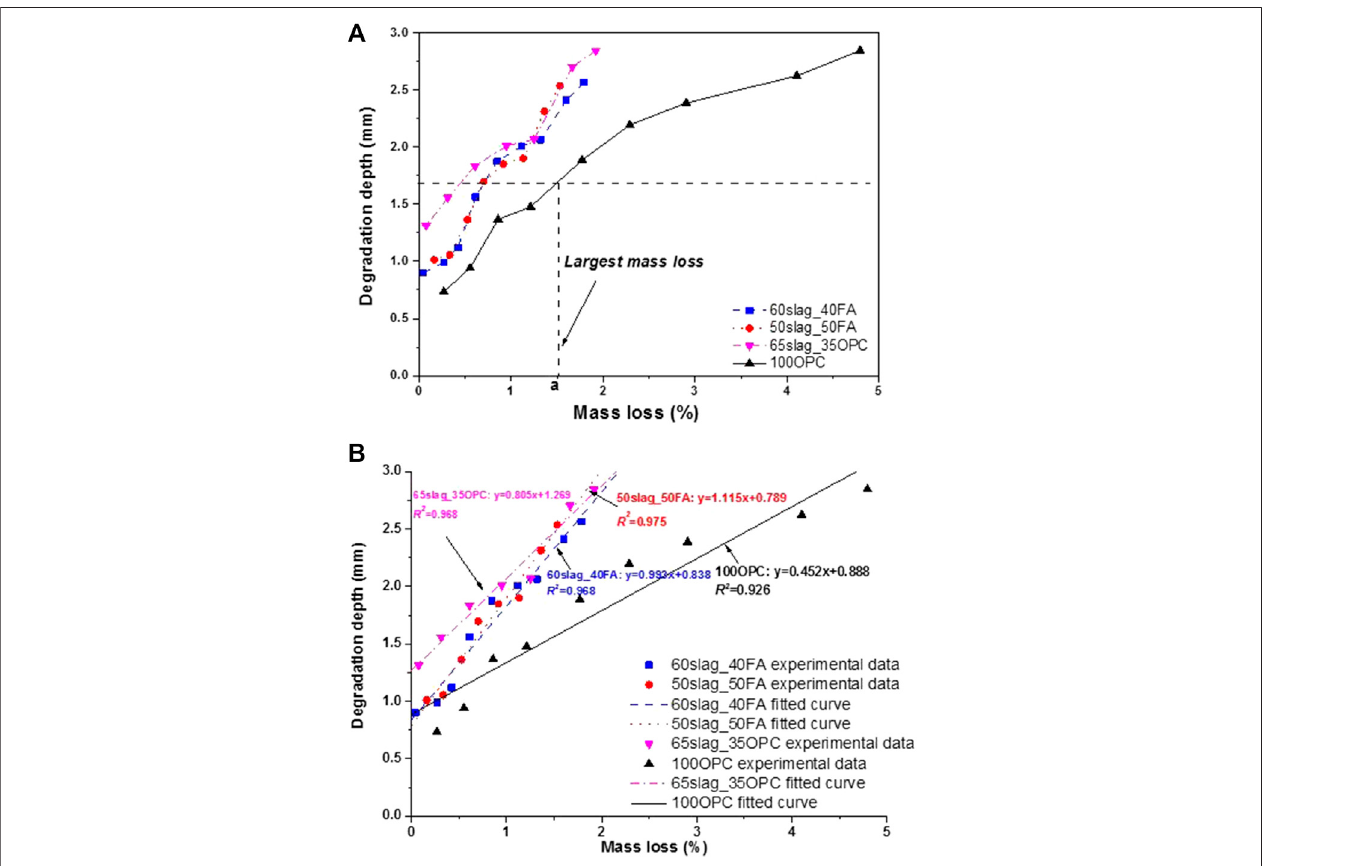
FIGURE8|(A) Therelationshipbetweentotaldegradationdepth(mm)andmassloss(%)forallmortarmixesduringtheexposureinthephosphoricacidwithpHat 2. Note: the plot only includes mass losses (no mass gains) and their corresponding degradation depth. (B) Linear fi tting of the curves.